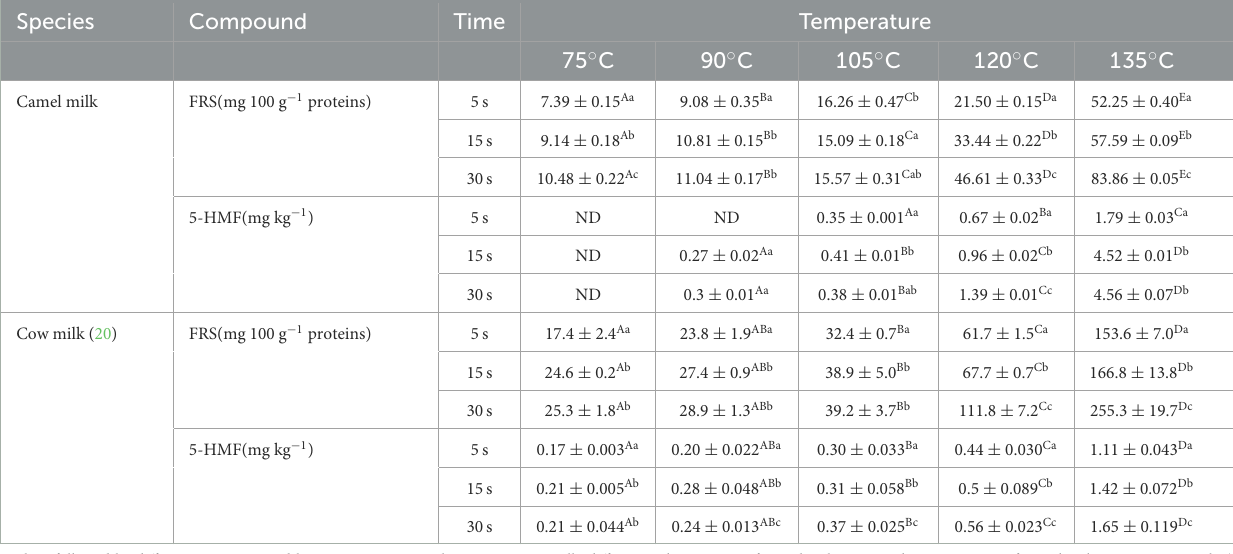
TABLE 1 Comparison of furosine and 5-hydroxymethylfural contents in camel milk and milk with different heat treatment degrees. Species Compound Time